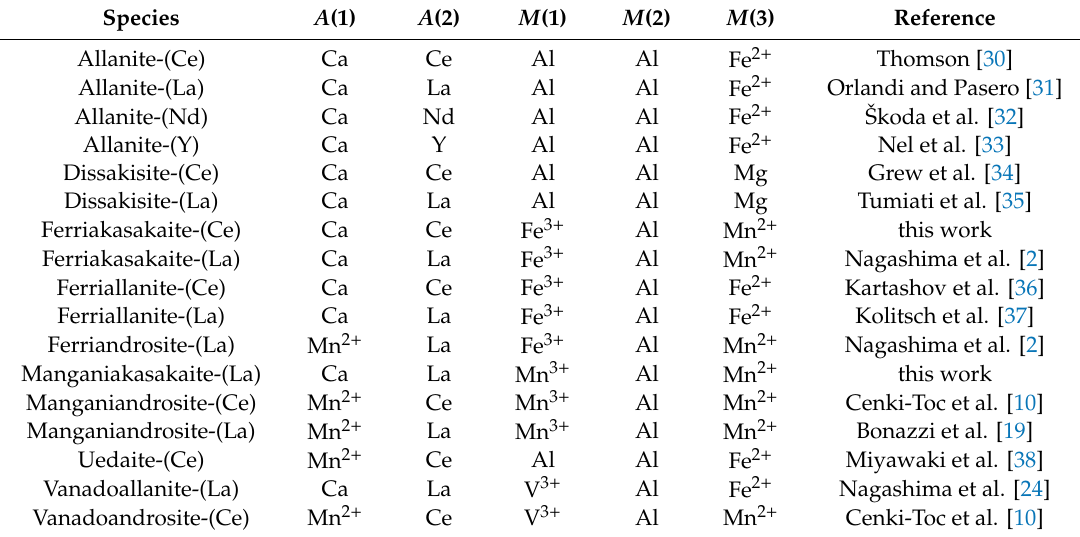
Table 9. Members of the allanite group within the epidote